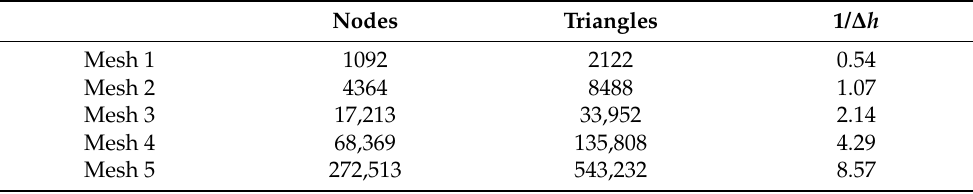
Table 1. Properties of meshes used for convergence study; ∆ h represents average element